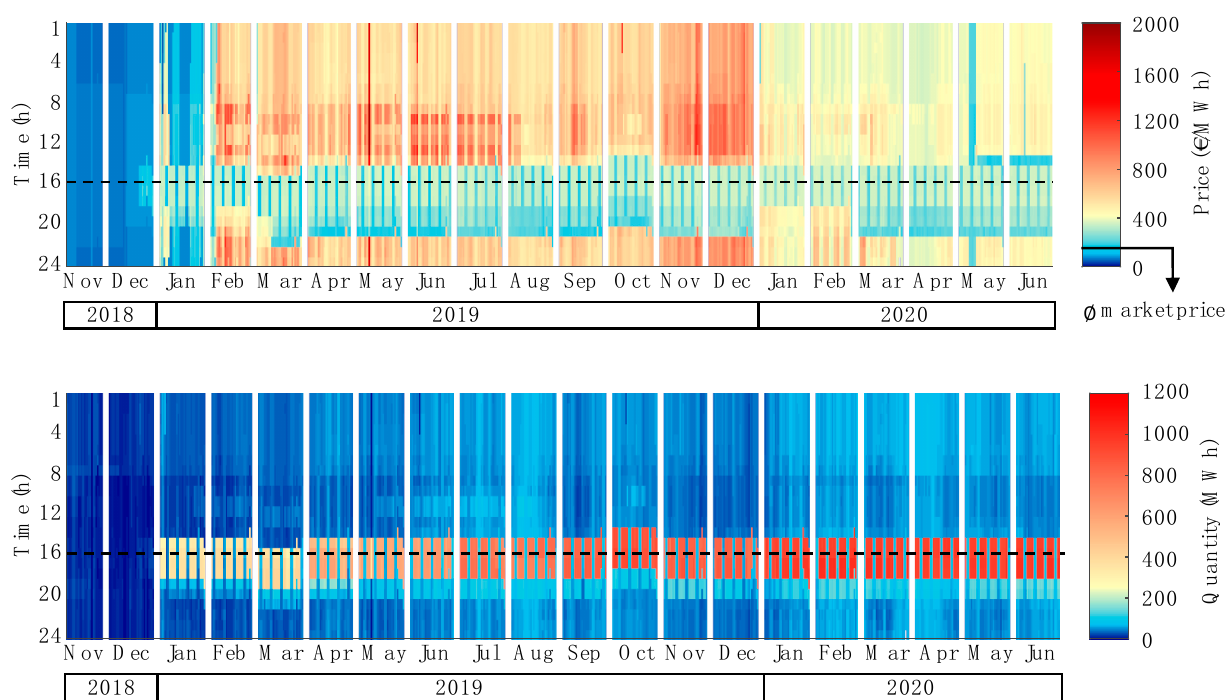
Figure 8. Heatmap of upward bids by UVAMs in terms of weighted average offered price (chart above ) and summed offered quantity (chart below ) with hourly resolution in the timeframe November 2018 to February 2020.